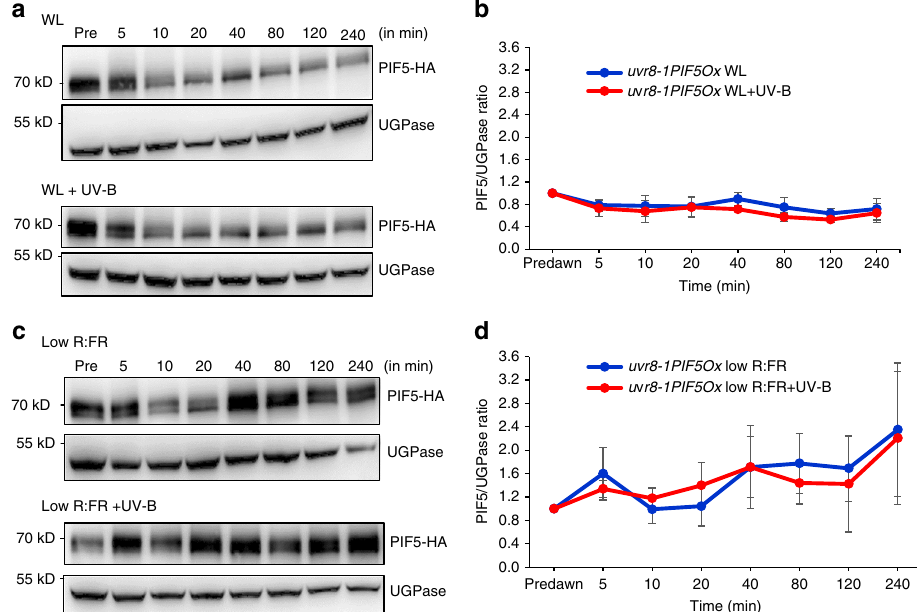
Fig. 3 UVR8 controls UV-B-mediated decreases in PIF5 protein abundance in high R:FR and low R:FR. a Western blots of PIF5-HA and UGPase in uvr8- 1PIF5Ox seedlings grown for 10 days in 16 h light/8 h dark cycles before transfer at dawn to high R:FR ± UV-B. b Quanti fi cation of PIF5 protein in three independent biological repeats. c Western blots of PIF5-HA and UGPase in uvr8-1PIF5Ox seedlings grown for 10 days in 16 h light/8 h dark cycles before transfer at dawn to low R:FR ± UV-B. d Quanti fi cation of PIF5 protein in three independent biological repeats. Bars represent s.e.m. Source data are provided as a source data fi